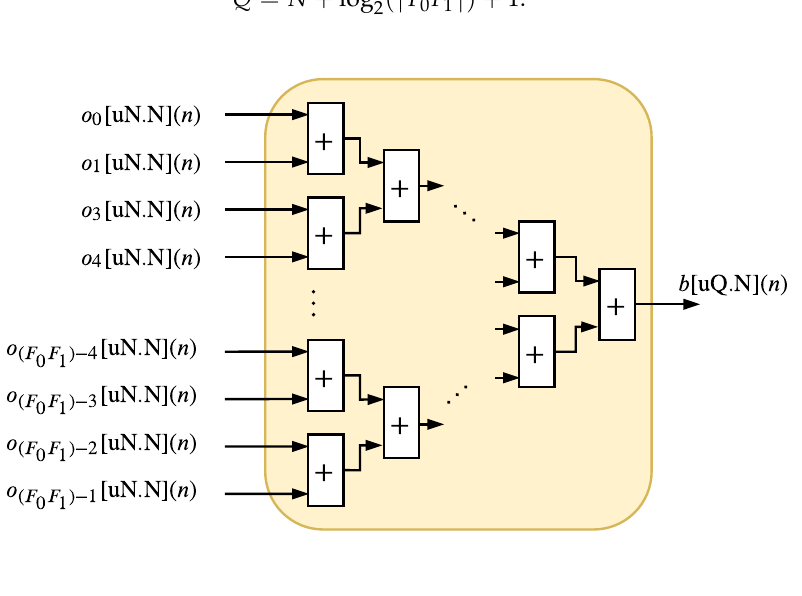
Figure 12. Hardware architecture of the